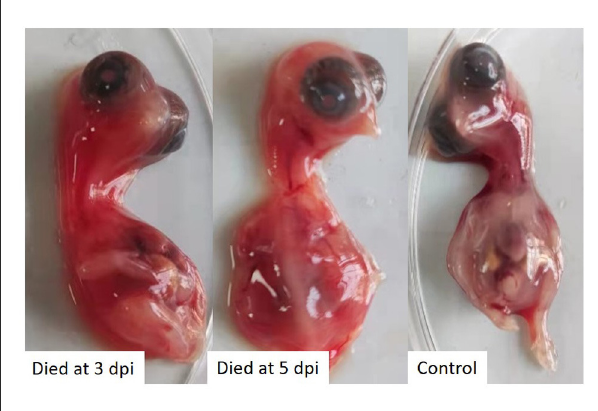
FIGURE1 SPF chicken embryos infected with TMUV-GX died and showed severely congestion and hemorrhage.